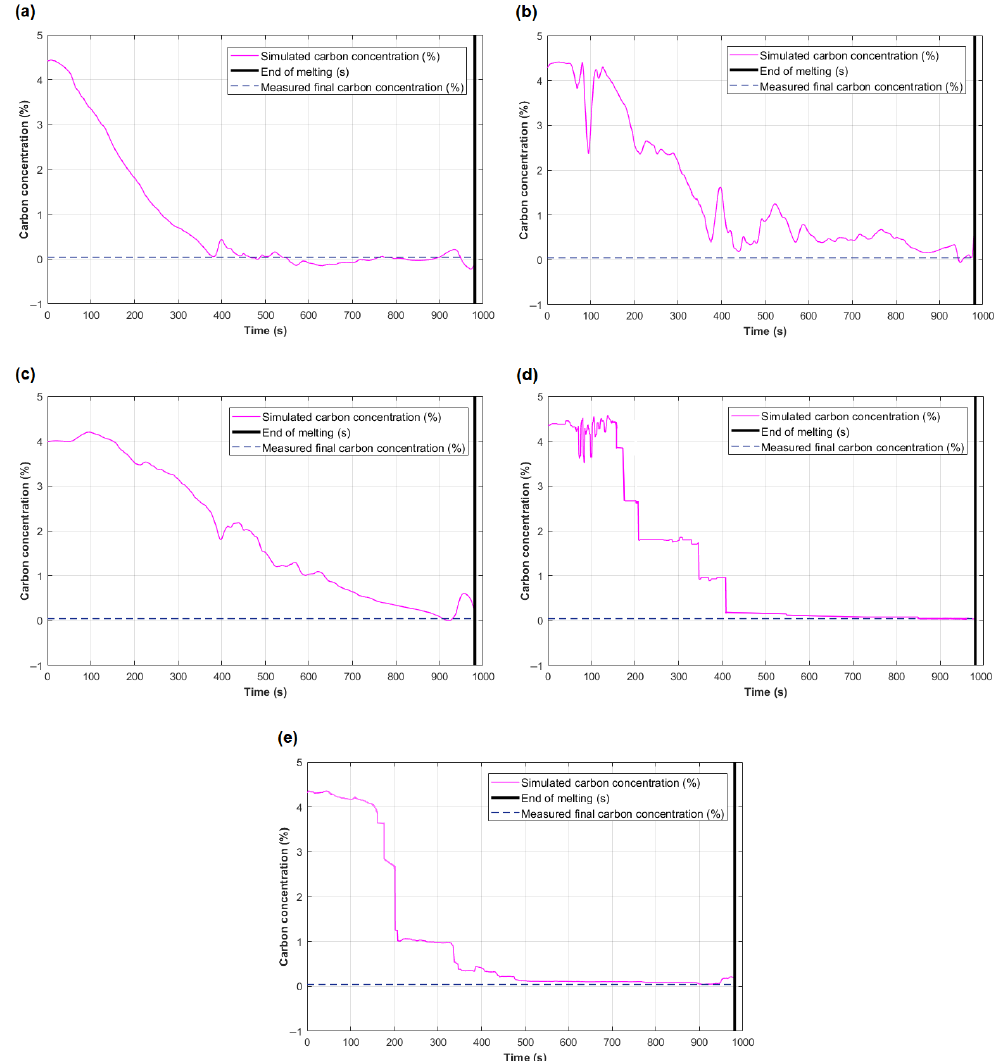
Figure 21. Prediction of carbon concentration in the melt from dynamic observations by ( a ) SVR model with polynomial kernel, ( b ) SVR model with Gaussian kernel, ( c ) NN model, ( d ) k -NN model, ( e ) RF